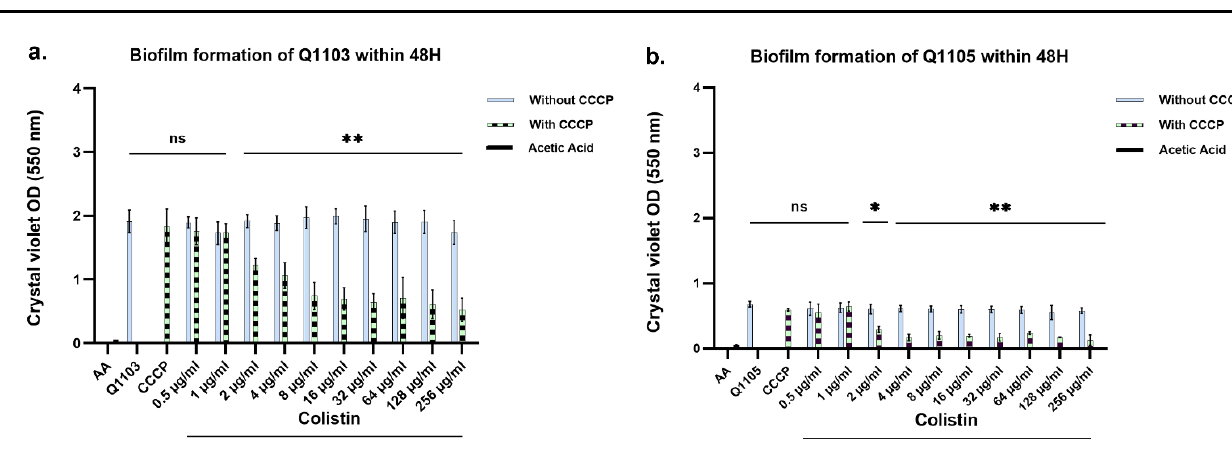
Figure 5. Time-kill curves of the combination of CO (2 µg/mL) and CCCP (10 µg/mL) of populations 1 and 2 of B. intermedia strains Q1103 and Q1105. Population 1: CCCP-MIC (alone) >10 µg/mL; Population 2: CCCP-MIC (alone) < 10 µg/mL ( p < 0.05); CO: colistin; CCCP: carbonyl cyanide 3-chloro phenyl hydrazone; DMSO: di-methyl-sulfoxide.